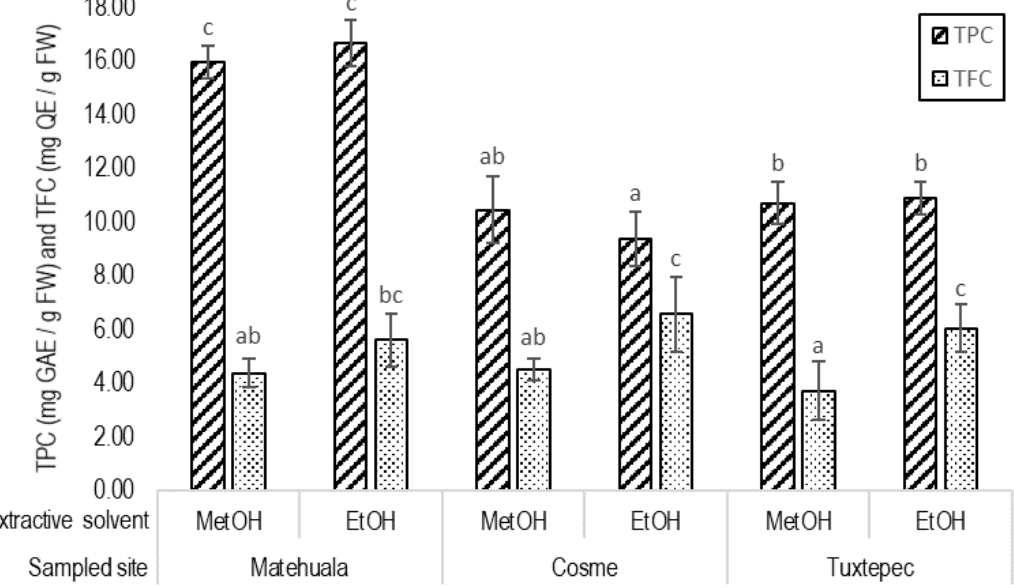
Figure 4. Total polyphenol content (TPC) expressed in milligrams gallic acid equivalent (GAE) and total flavonoid content (TFC) in quercetin equivalent (QE) per gram of fresh weight (FW) measured in methanolic (MetOH) and ethanolic (EtOH) extracts of Agave lechuguilla by-product from three different regions. Different letters indicate significant difference resulting from the one-way ANOVA and Tukey post-hoc test, respectively, performed on TPC and TFC (n = 12, p -value < 0.05).